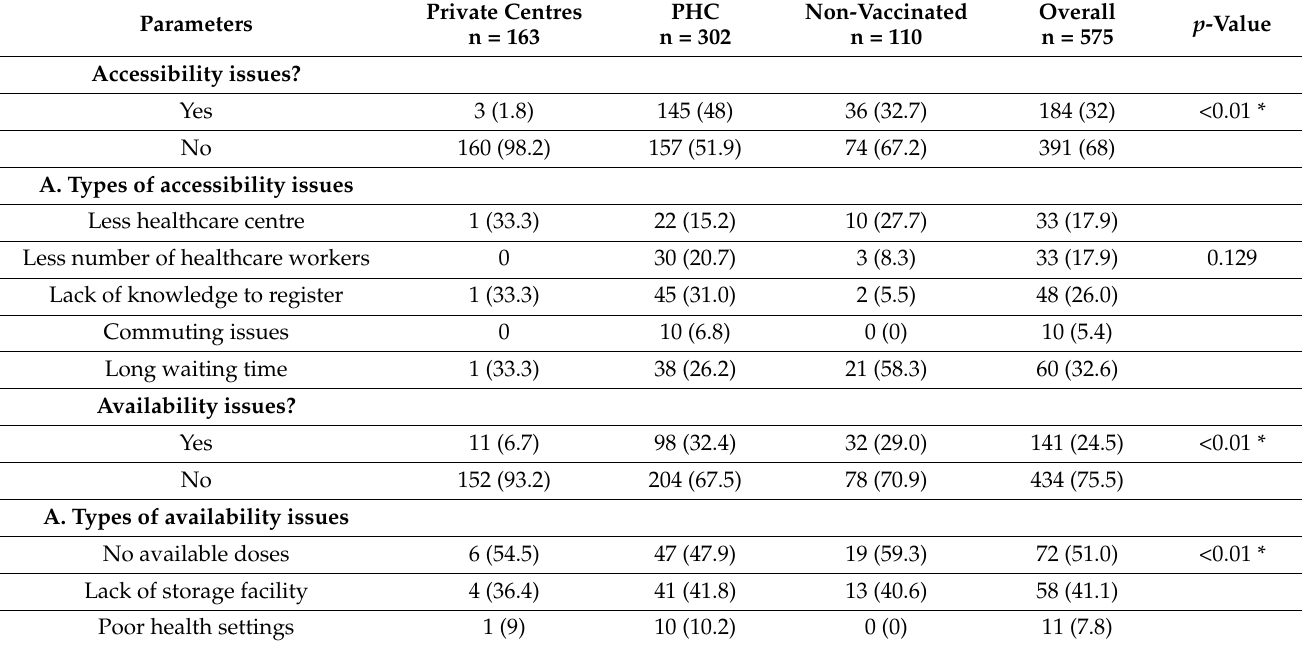
Table 3. Accessibility and availability issues among the